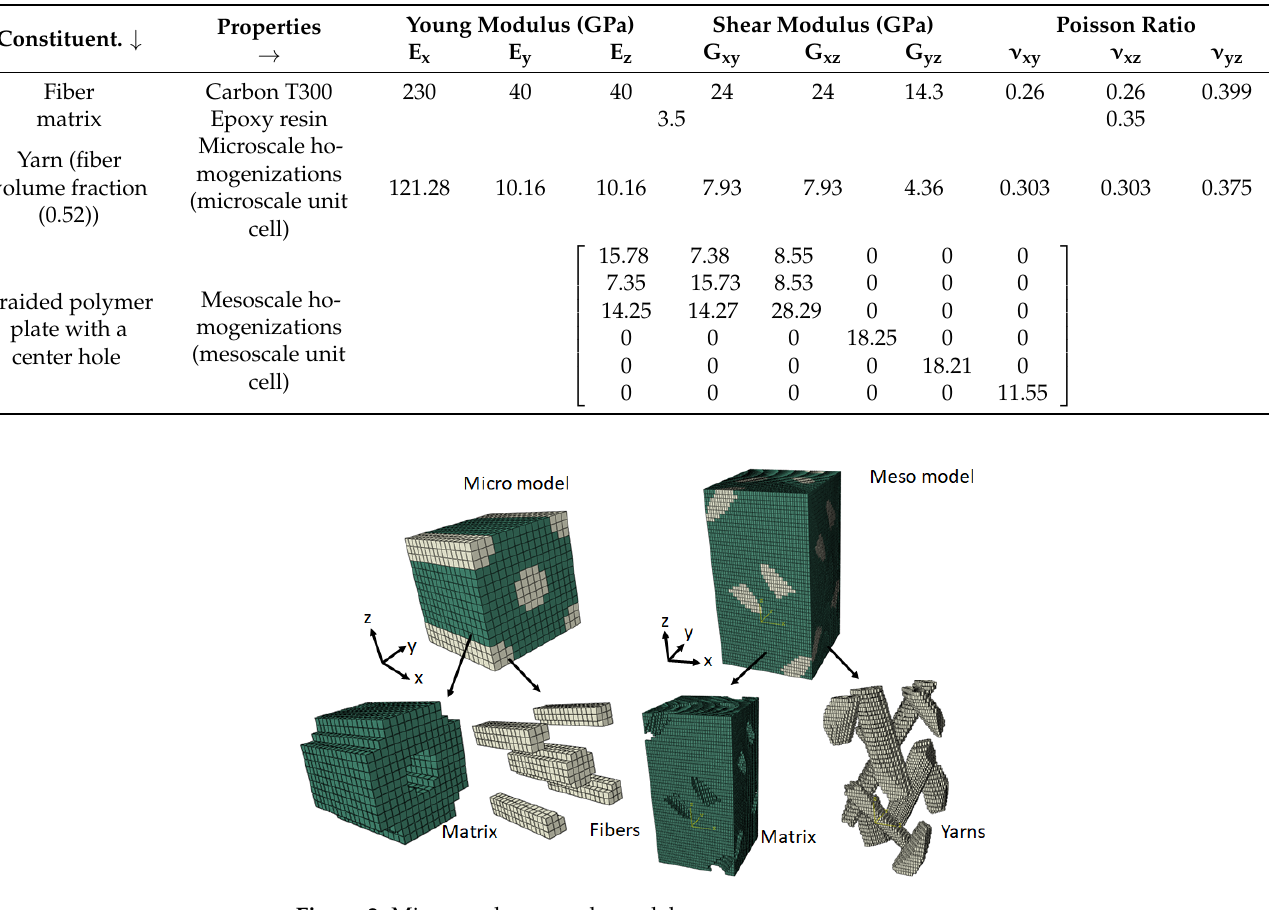
Figure 2. Micro- and mesoscale models.